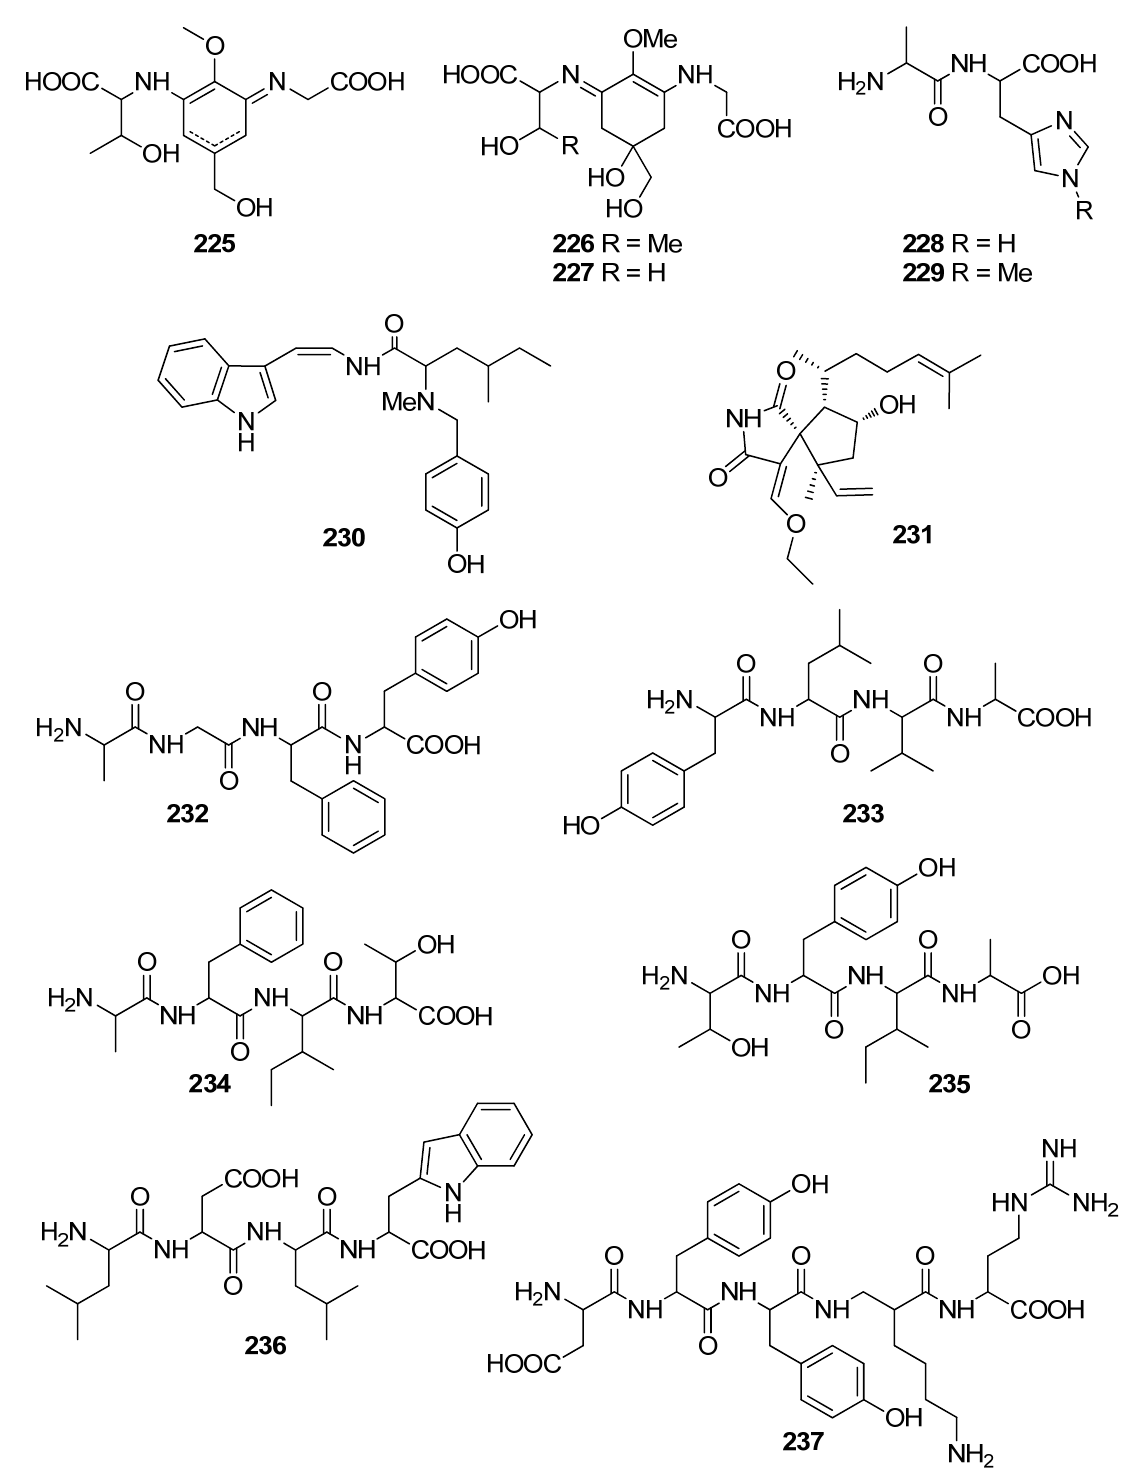
Figure 20. Chemical structures of compounds 225 – 237 . The characteristic pigments of the light harvesting proteins phycoerythrobilin ( 239 ), pheophorbide a ( 240 ), chlorophyll β ( 241 ) and pyropheophytin α ( 242 ) have been found to exert antioxidant activity [141,201–206]. It seems that the porphyrin ring system is im- portant for the expression of antioxidative activity in the dark. Indeed, phycoerythrobilin ( 239 ) showed potent antioxidant activity in in vitro experiments and significantly inhib- ited the release of β -hexosaminidase in rat basophilic leukemia cells [207], suggesting that